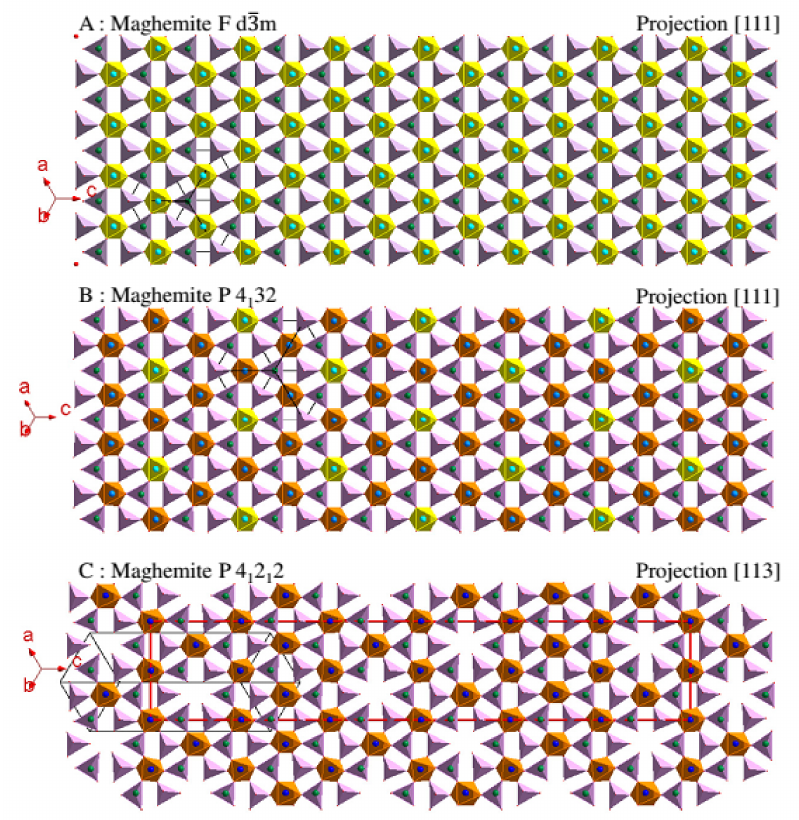
Figure 2. ( A ) Projection [111] of maghemite Fd3m. ( B ) Projection [111] of maghemite P4 1 32. ( C ) Pro- jection [113] of maghemite P 4 1 2 1